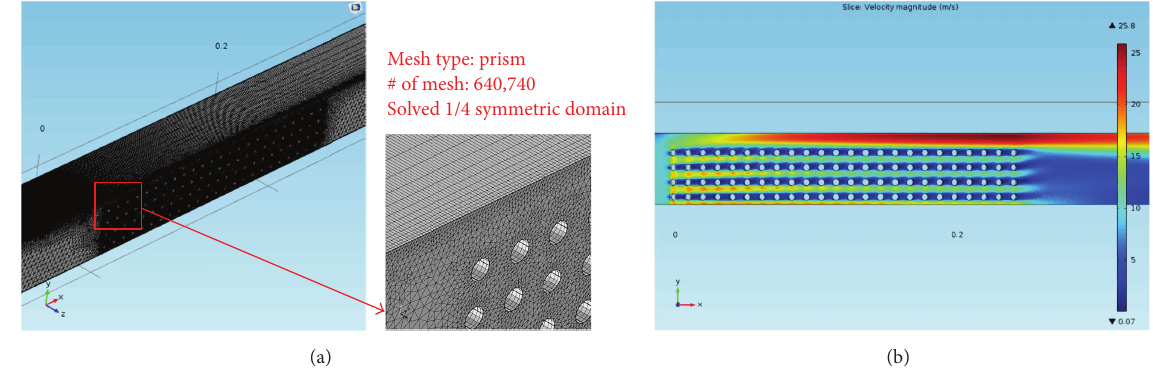
Figure 2: COMSOL computation: (a) grids system and (b) velocity